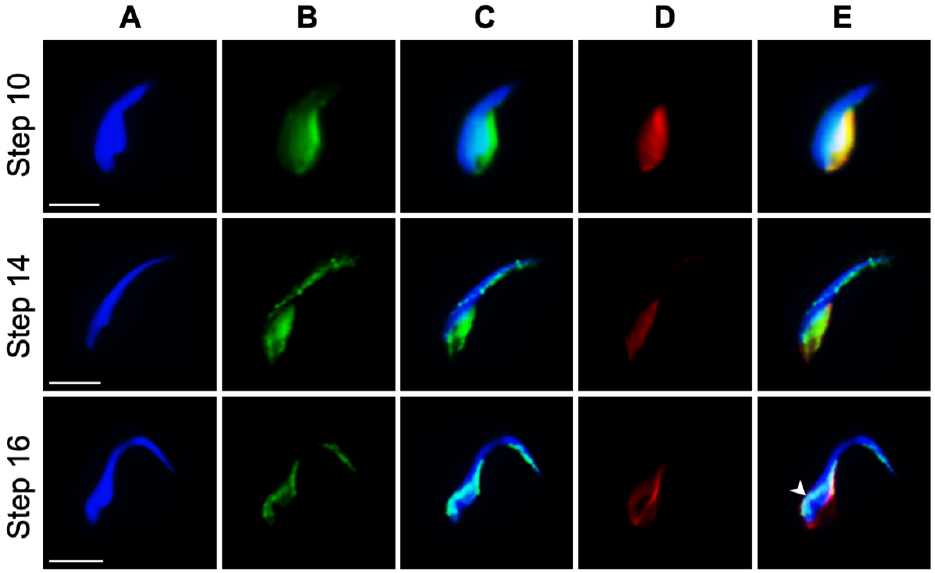
Figure 8. Immunofluorescent micrographs of the co-localization of the pan- α -histone and α -tubulin antibody labeling on the caudal manchette of rat spermatids. Rat spermatids from testicular extracts were fixed in 2% formaldehyde and permeabilized after fixation with Triton-X-100: ( A ) DAPI alone; ( B ) anti-histone antibody alone; ( C ) panels A and B merged; ( D ) anti-tubulin antibody alone; ( E ) panels A, B, and D merged. Note in step 14 the histones are already deposited apically into the perforatorial region of the spermatid head, while in step 16 the histones assemble as part of the PAS (arrowhead) in the wake of the descending manchette. Blue = DAPI, green = anti-pan histone, red = anti-tubulin, yellow = co-localization of the histones and tubulin. White bar = 5 μ m. Also see Figure S5.